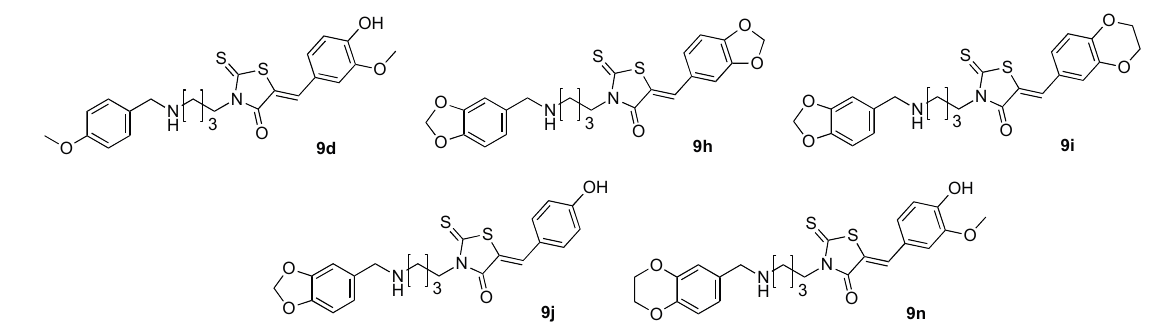
Figure 2. Structure of compounds 9d , 9 ( h – j ) and 9n , which are active against protein kinases and/or tumor cell